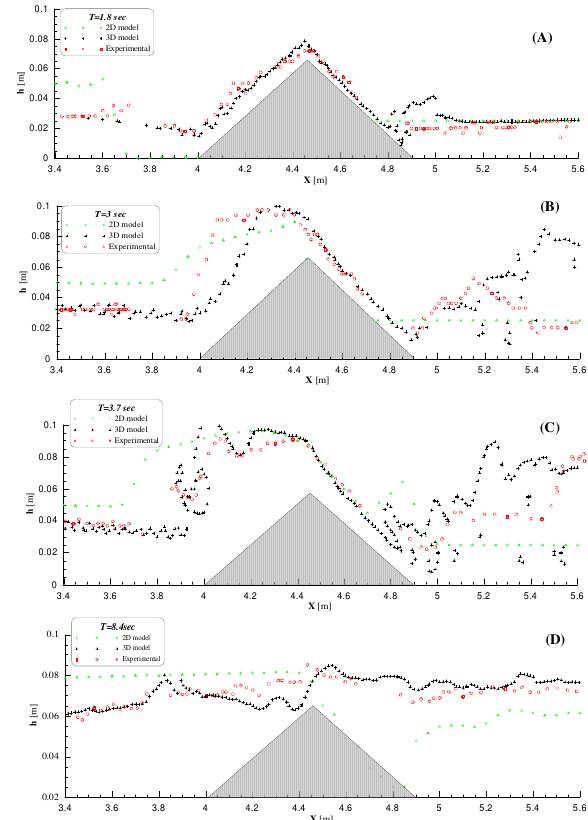
Fig. 12. Two-dimensional model, three-dimensional model, exper- imental water surface profile at T =1.8s (a) T =3s (b) T =3.7s (c) , T